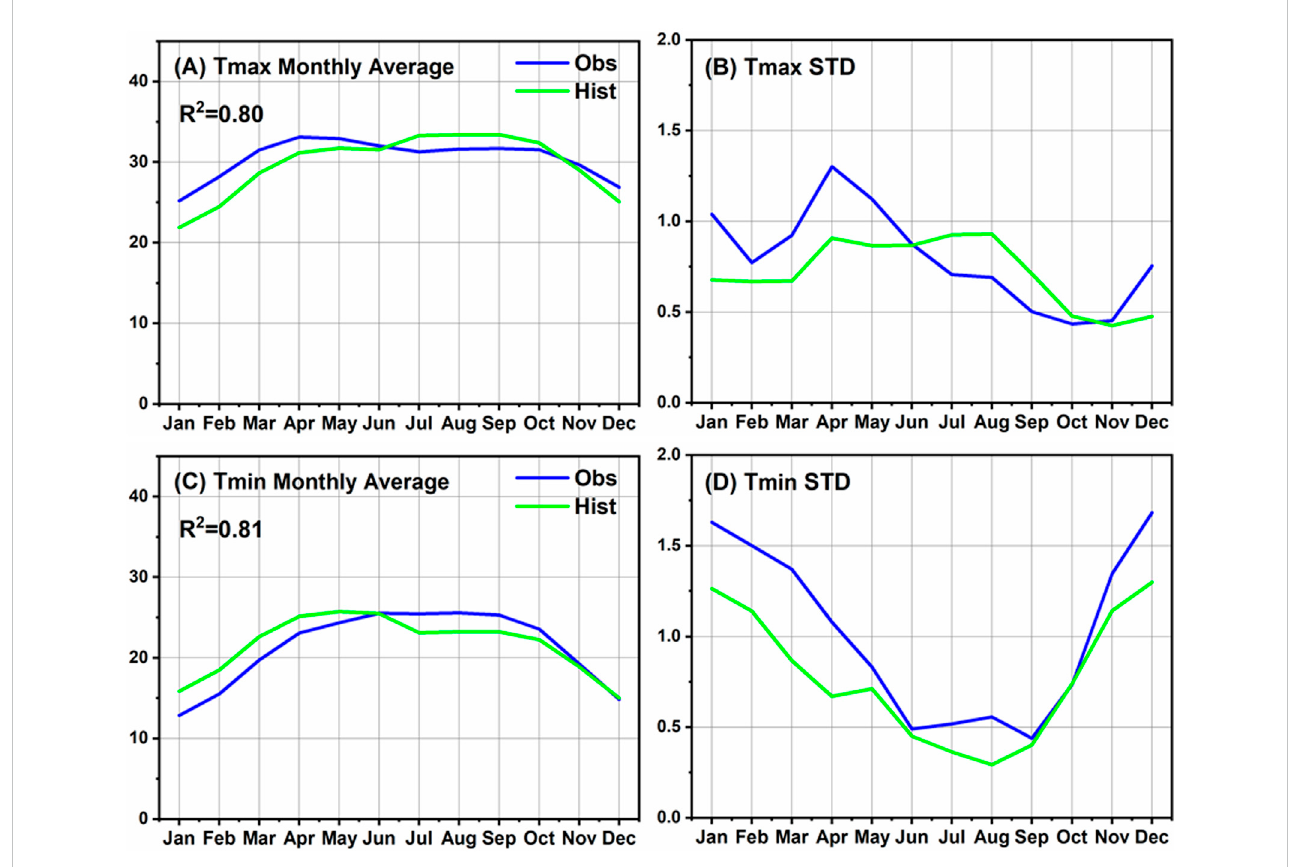
FIGURE 2 Comparison of observed and historical GCM of maximum temperature (Tmax) and minimum temperature (Tmin) for the period 1986 – 2005. (A,C) Monthly average, (B,D) Standard